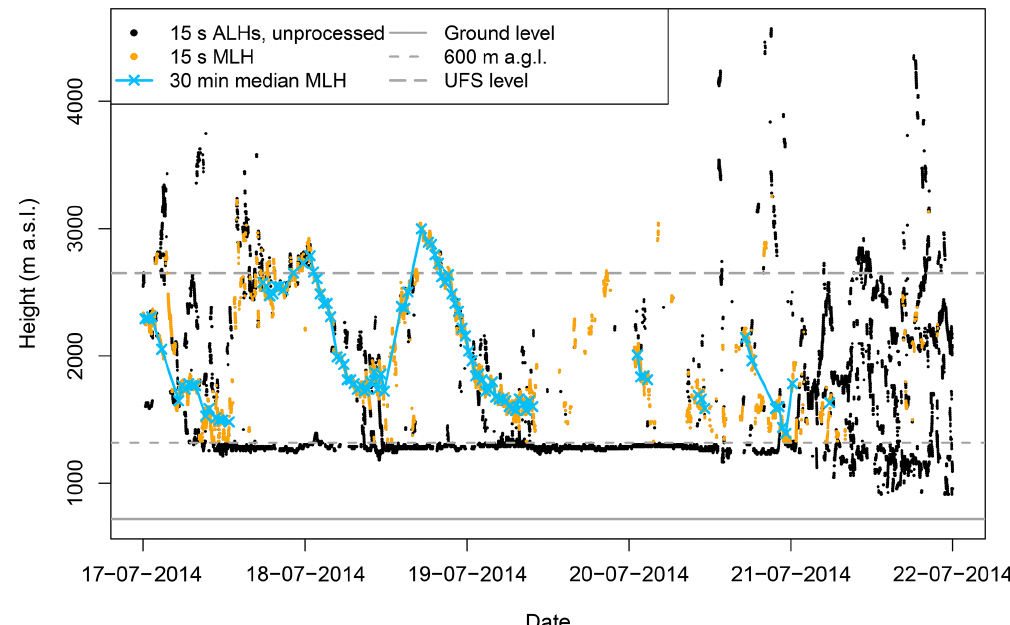
Figure 2. Post-processing of the ceilometer-based aerosol layer heights (ALHs), which were used to determine the mixing layer height (MLH) at GAP, illustrated for the period from 17 to 21 July 2014. Outliers have been removed from the MLH. Points of the 30min median MLH are connected by a line if separated by a maximum of